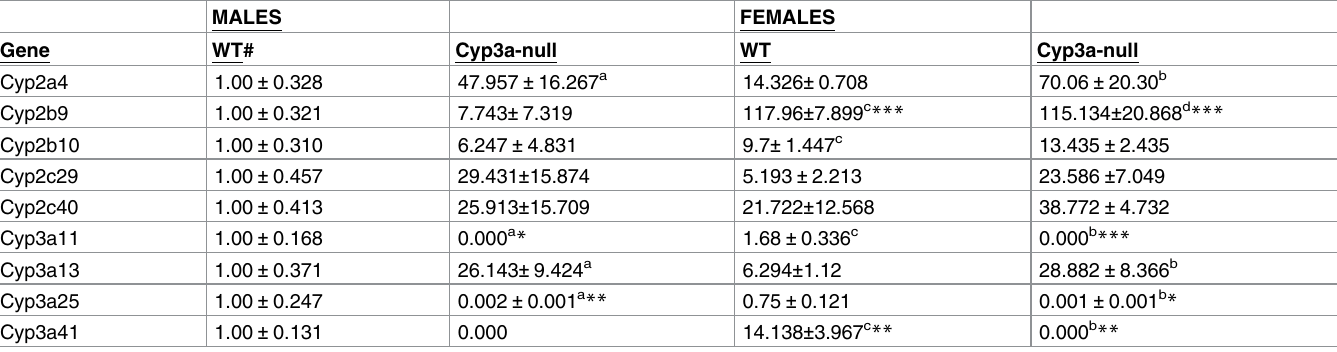
Table 2. Compensatory changes in CYP gene expression in Cyp3a-null